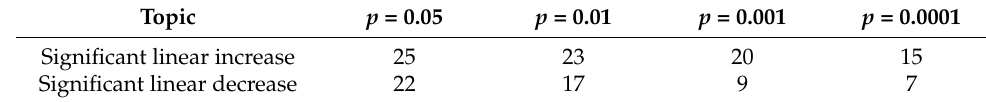
Table 5. Topic significance classifications.